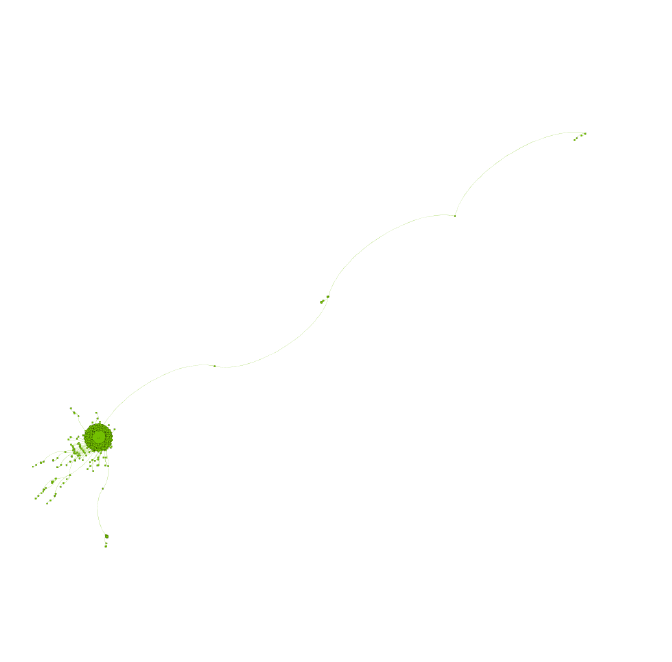
Figure 6. SC2 is the second largest sub-community and is centred on the South Beach Diet.